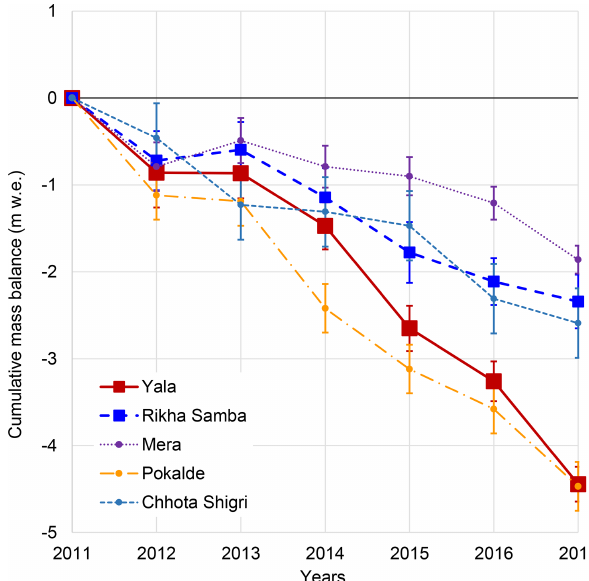
Figure 13. Cumulative mass balances of Yala, Rikha Samba, Mera, Pokalde and Chhota Shigri glaciers. The data for Mera, Pokalde and Chhota Shigri glaciers are from Wagnon et al. (2013), Sherpa et al. (2017), WGMS (2021), Wagnon et al. (2020) and Mandal et al.